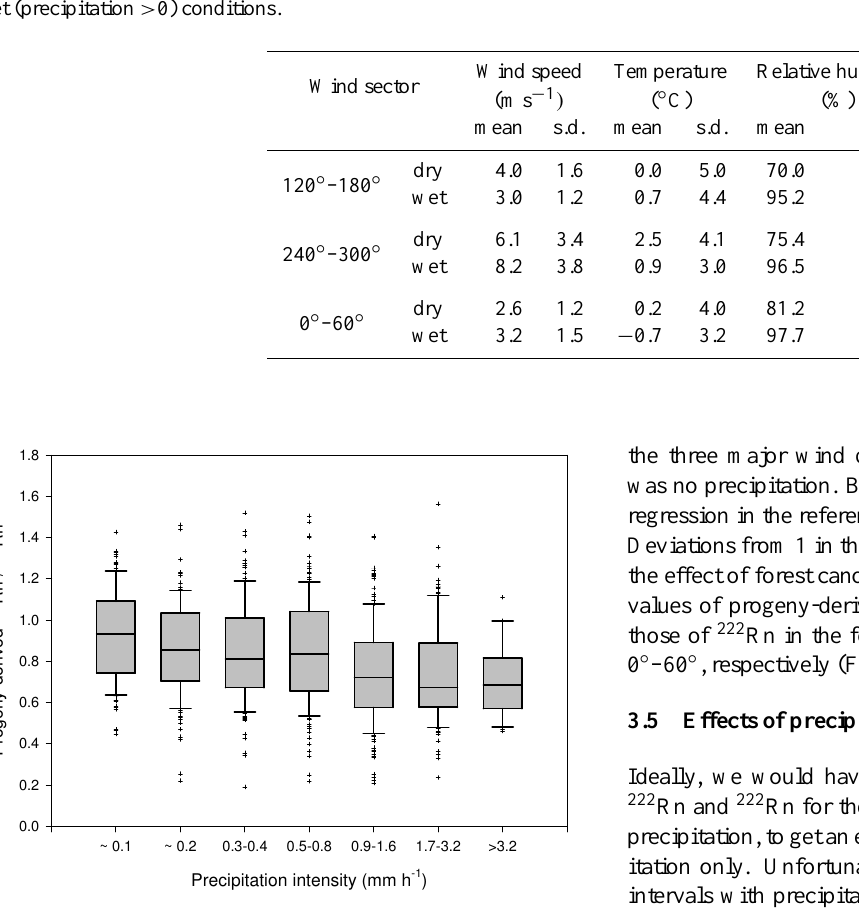
Fig. 6. Ratio of the activity concentrations of progeny-derived 222 Rn and 222 Rn summarized for different ranges of precipitation intensity (instrumental background and calibration have been harmonized between detectors). Boxes indicate median, upper and lower quartile, whiskers 10 th and 90 th percentile, crosses are outliers. Each range includes between about 120 and 180 hourly values, except for precipitation intensities >3.2 mm h -1 (n =29). The lowest precipitation intensities are near the detection limit of the instrument and therefore only approximate.